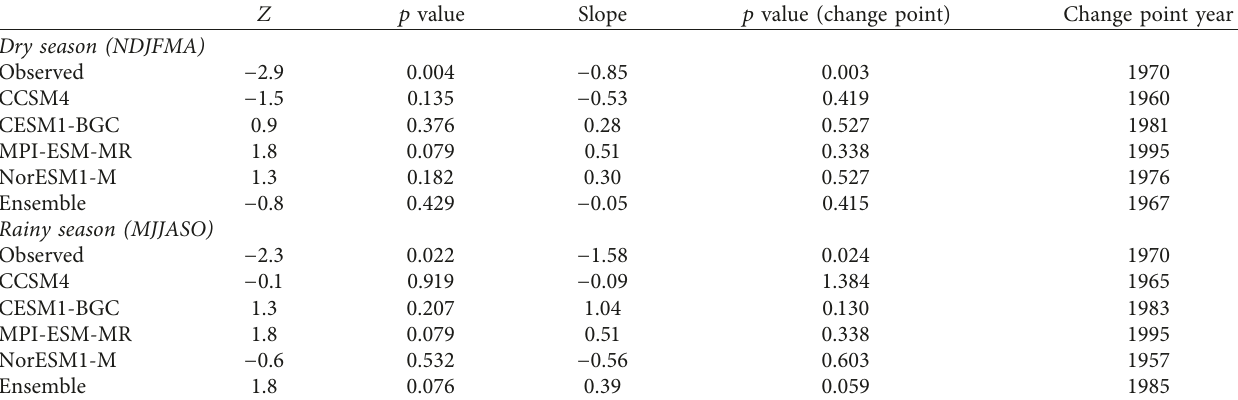
Table 2: Trend test for the Volta Basin rainy and dry seasons.